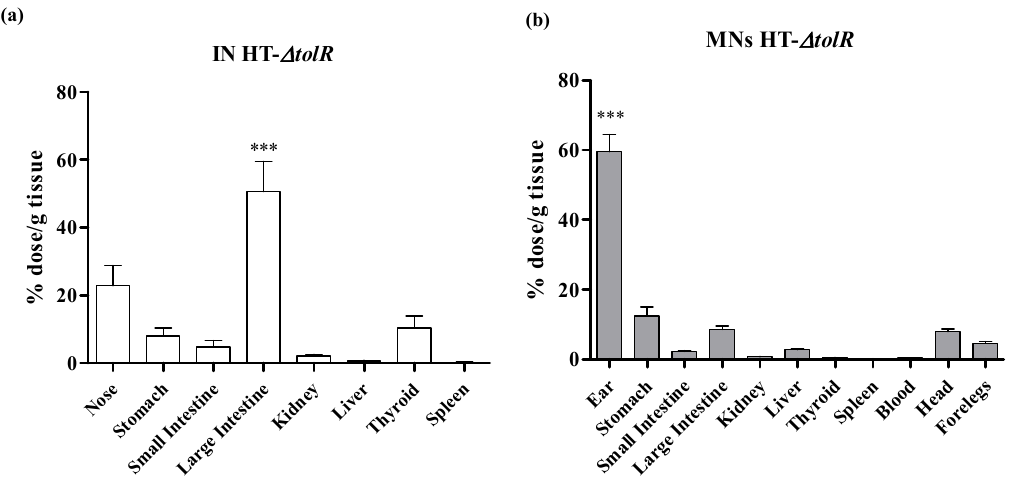
Figure 9. Biodistribution of radiolabeled HT- ∆ tolR after nasal or intradermal administration in BALB/C mice. Percentage (%) of 99m Tc activity in the different organs 6 h after ( a ) intranasal, IN or ( b ) microneedles (MN) intradermal administration of 20 μ g HT- ∆ tolR . Due to the different organs evaluated in each route, results were evaluated separately. The results show the mean and SD ( n = 5) (***, p < 0.001). IN: intranasal; MNs: microneedles.